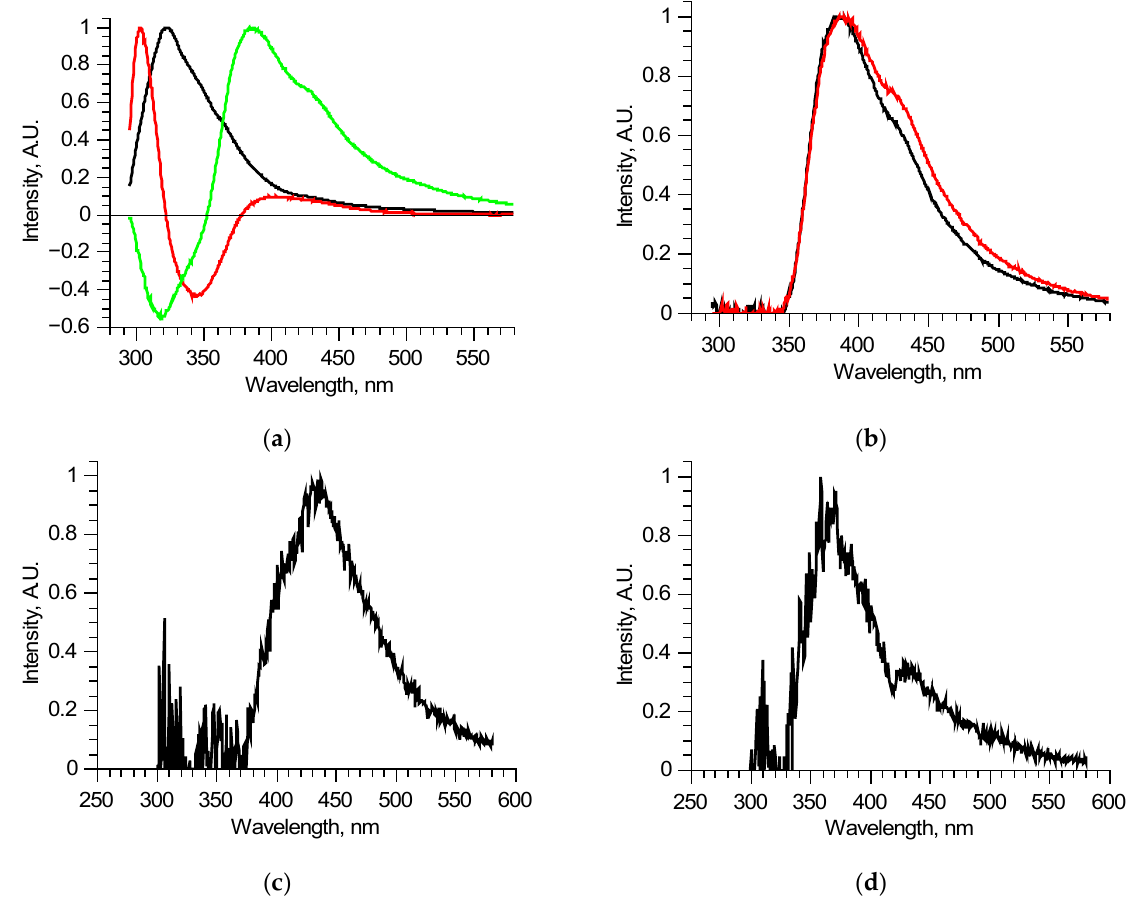
Figure 3. Analysis of separate excitation–emission matrices for 210–290 nm laser radiation wavelengths: principal compo- nents of an individual matrix ( a ); reconstructed long wavelength fluorescent component spectra for two similar matrices ( b ); differential spectrum derived from two components ( c ); an example of a reconstructed long wavelength fluorescent component spectrum with signs of reabsorption ( d ).